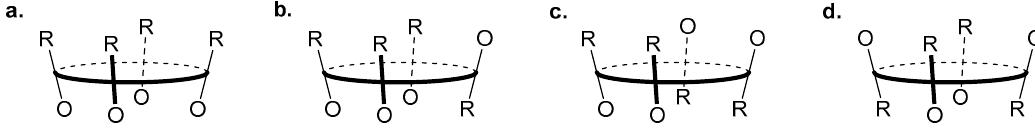
Figure 6. Schematic representation of the four conformations of calix[4]arene which show the different possible orientations of the phenolic oxygens: ( a ) cone; ( b ) partial cone; ( c ) 1,2-alternate; ( d ) 1,3-alternate [83].